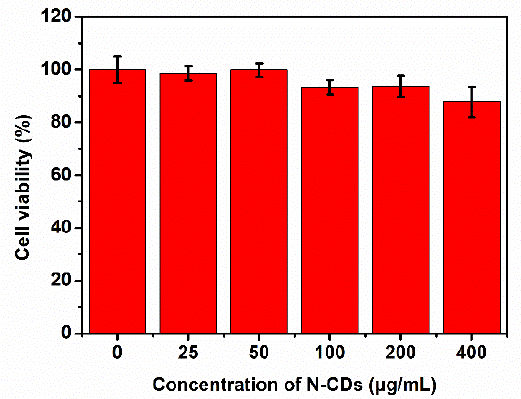
Figure 6. Cell viability of A549 cells after incubation with N–CDs with different concentrations. (Untreated cells served as the control, whose viability was set as 100%).